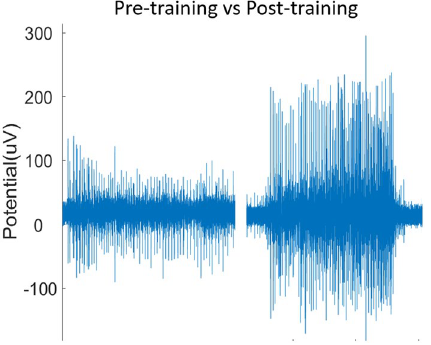
Figure 4. ENG signal from participant 1 during ring finger flexion. The plots represent the ENG signal before and after the training procedure